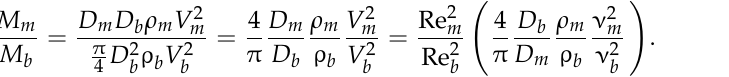
Table 1 cites the mixing regimes vs. the flow Reynolds number ratio in the main pipe and the momentum ratio in the